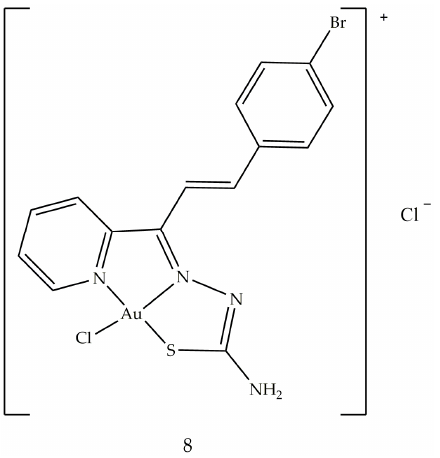
Figure 6. Molecular structure of the gold (III) thiosemicarbazone (8).